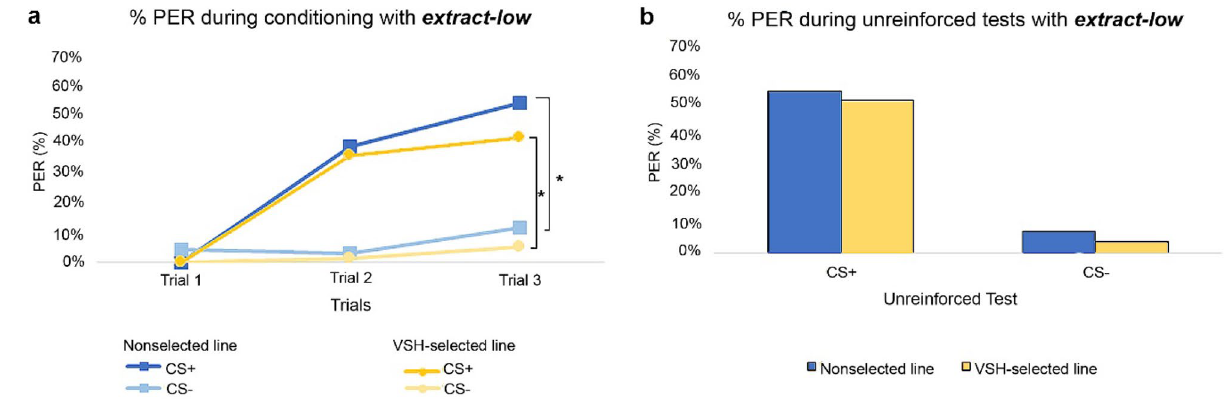
Figure 1. Drone performance during PER-conditioning experiment with extract-low . Acquisition ( a ) and results from the unreinforced tests ( b ) are shown for both stimuli (CS+ and CS−) and origins (nonselected line, VSH-selected line). The curves display the behavioural reaction—proboscis extension—for the reinforced (CS+) and the non-reinforced (CS−) stimulus. The bars show the behavioural reaction during the unreinforced tests with both stimuli. A total of 223 drones were tested using extract-low . The stimulus effect (reinforced, non- reinforced) was significant—(*) p < 0.001.